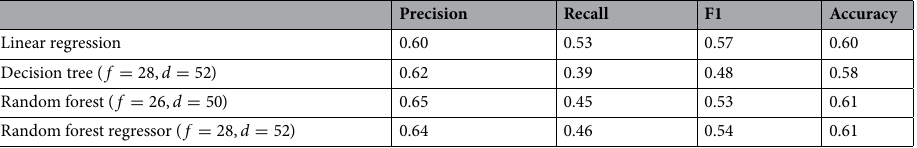
Table 2. Four different classifiers are trained on a sample of 50% of the filtered and labelled dataset, and then we test their performance on the other 50% of the data across four metrics. In each instance the features used ( f ) and tree depth ( d ) are selected to maximise accuracy.